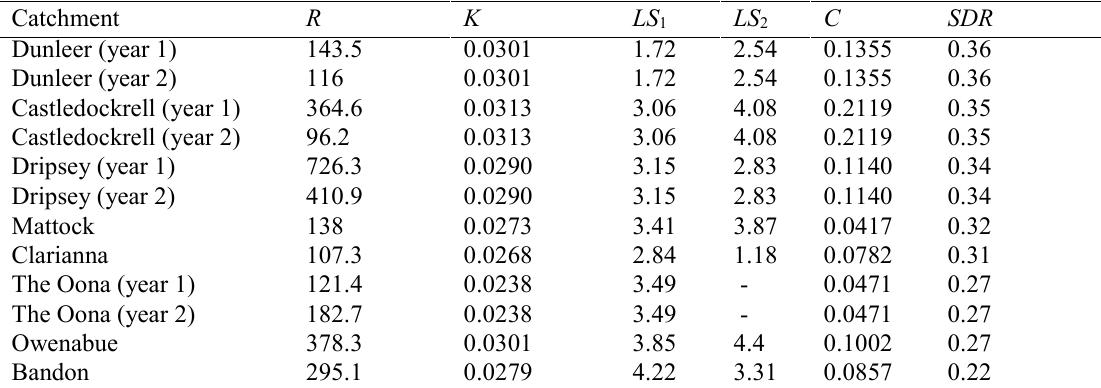
Table 2 Estimates of mean RUSLE factors and SDR for Irish catchments. Catchment